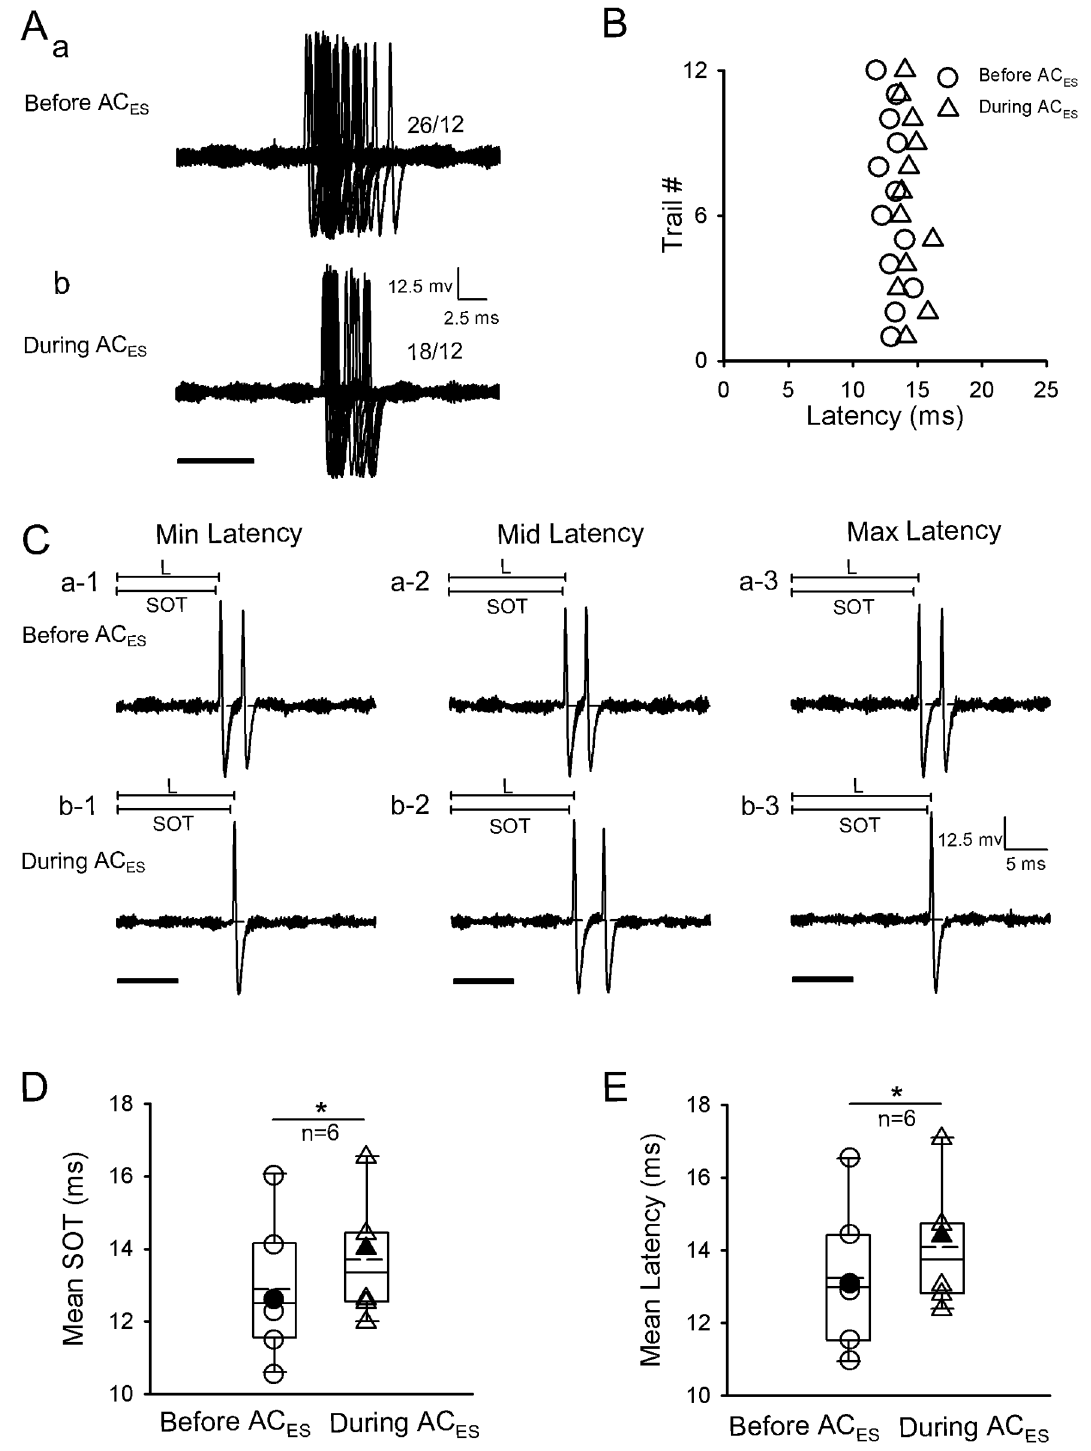
Fig 7. Representative inhibited IC neuron by AC ES showing its latency increasing induced by SOT backward-shift. (A) Original responsetraces obtainedby 12 repetitive pure tone stimulationconditions before (Aa) and during(Ab) AC ES . (B) Distributionof latency values calculatedaccordingto Aa and Ab before (unfilledcircle) and during(unfilledtriangle)AC ES . (C) Three representative (i.e., minimum(a-1, b-1), middle(a-2, b-2), and maximum (c-1, c-2)) latenciesselectedfrom Aa and Ab before (Ca-1–a-3) and during(Cb-1–b-3) AC ES . (D) Comparison of mean SOTs for this type of IC